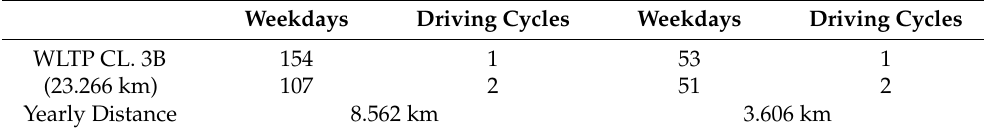
Table 12. Typical yearly vehicle utilization according to distance travelled in